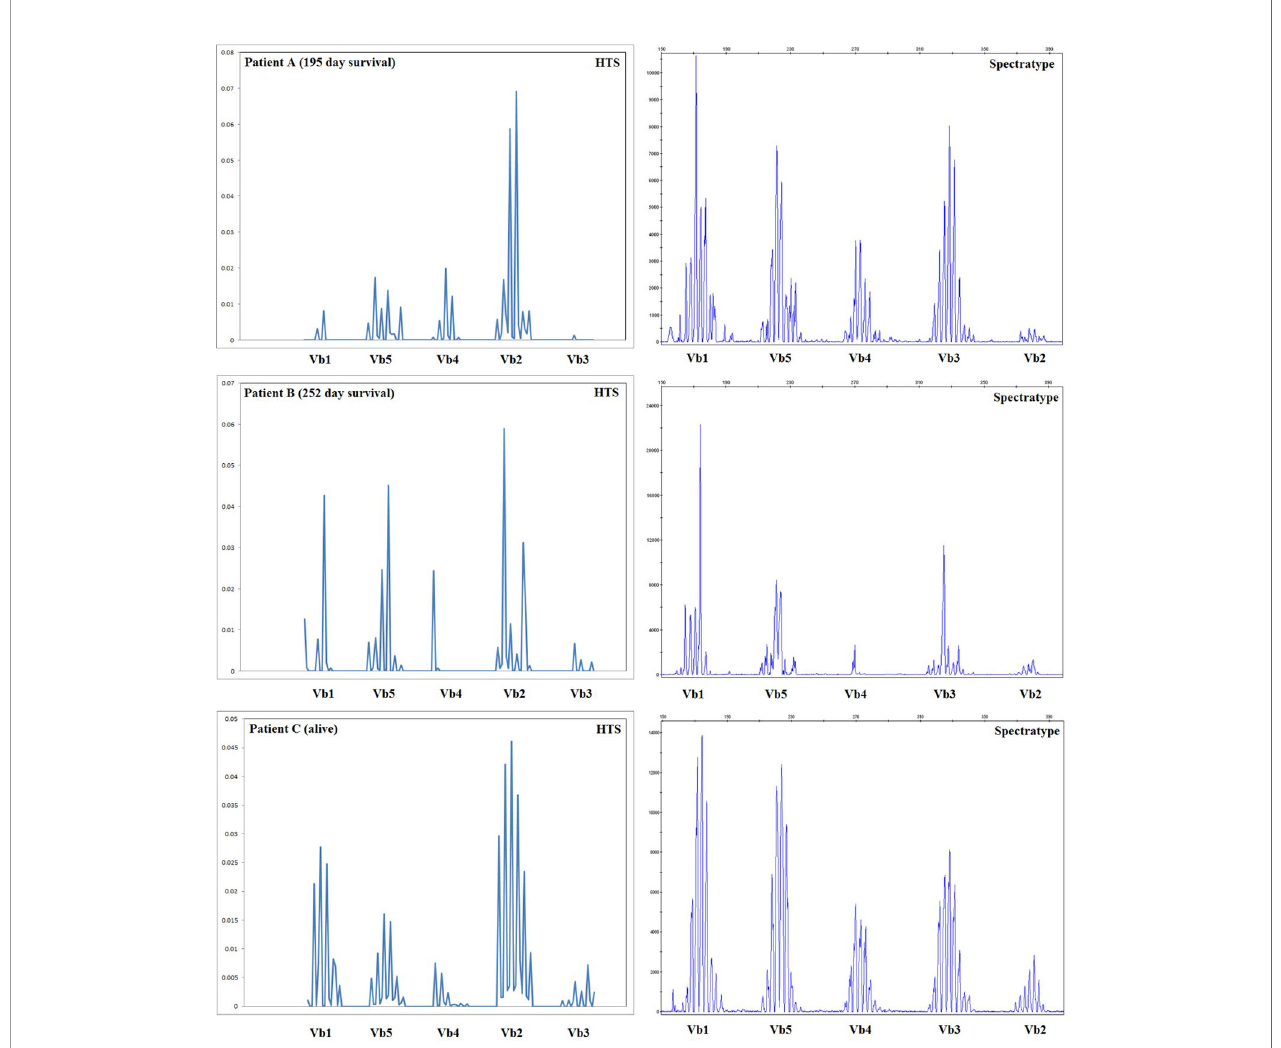
FIGURE 6 | Comparison of spectratype data with high-throughput sequencing. Here we present a subset of the data generated, including the results for Vb1 – Vb5 (i.e., one spectratype reaction) for three representative patients at 56 days posttransplant, including two patients who died during the fi rst year posttransplant and one patient who survived. For patients B and C, spectratyping and high-throughput sequencing (HTS) agree, indicating an oligoclonal repertoire in patient B and a diverse repertoire in patient C. Patient A appears much more oligoclonal in our high-throughput sequencing (HTS) data than in the spectratype data; HTS estimated a very low TCRB repertoire size for patient A, who went on to die 195 days posttransplant. Taken together, these data indicate that HTS and spectratyping data are in agreement when analyzed in a similar fashion, and HTS offers an additional depth of data and the advantage of quantitative rather than qualitative output.